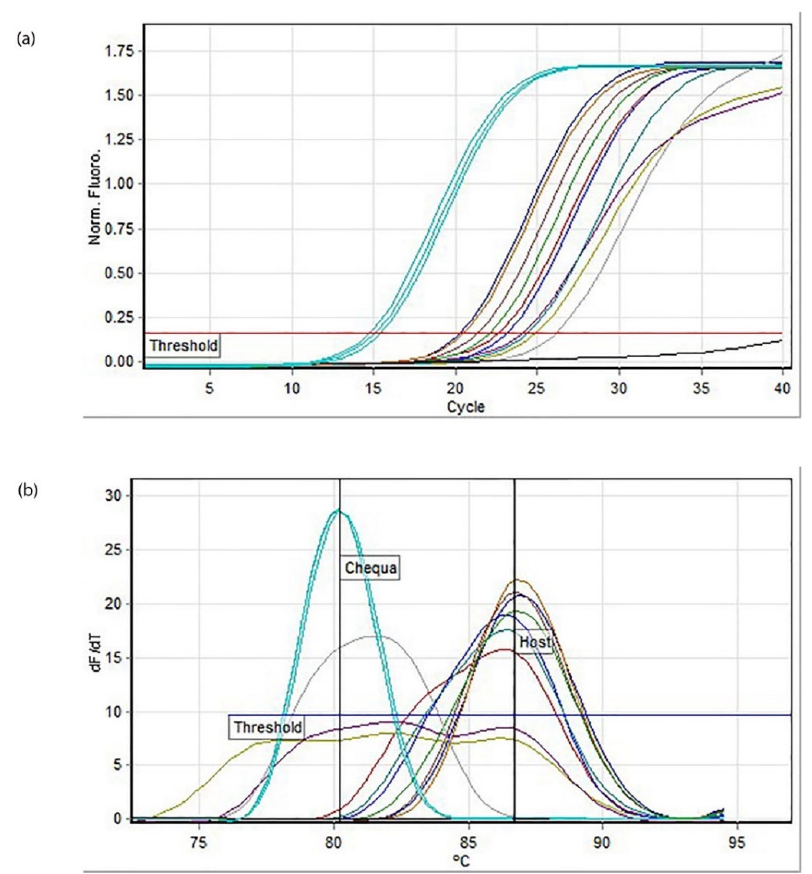
Figure 1. RT ‐ qPCR assay for Chequa iflavirus in all crayfish samples post ‐ injections in Experiment 1: ( a ) amplification plot, ( b ) melt analysis (Mean 86.7, SD 0.25). Blue represents Chequa iflavirus standards (10 7 ), and other colours represent the crayfish samples.